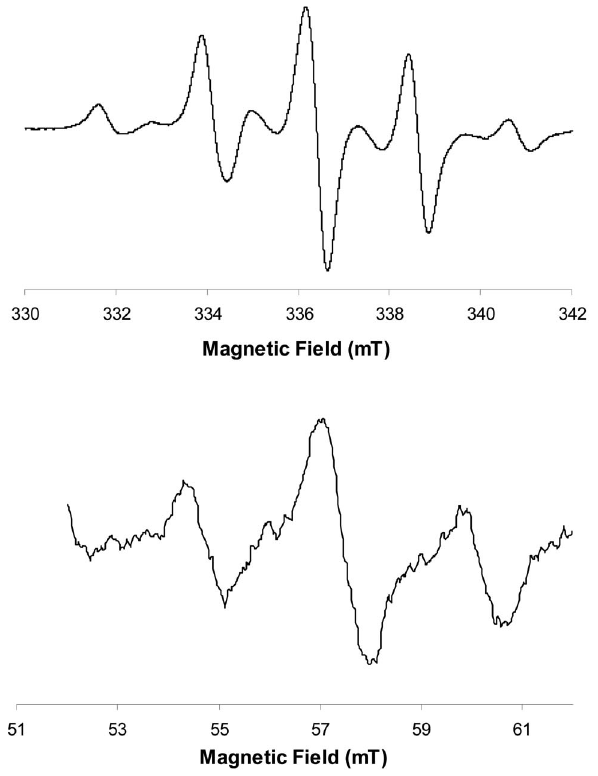
Figure 1. Typical 9 lines EPR spectrum observed in X-band (top) and L-band (bottom) for a commercial composite (Filtek Supreme Ultra).